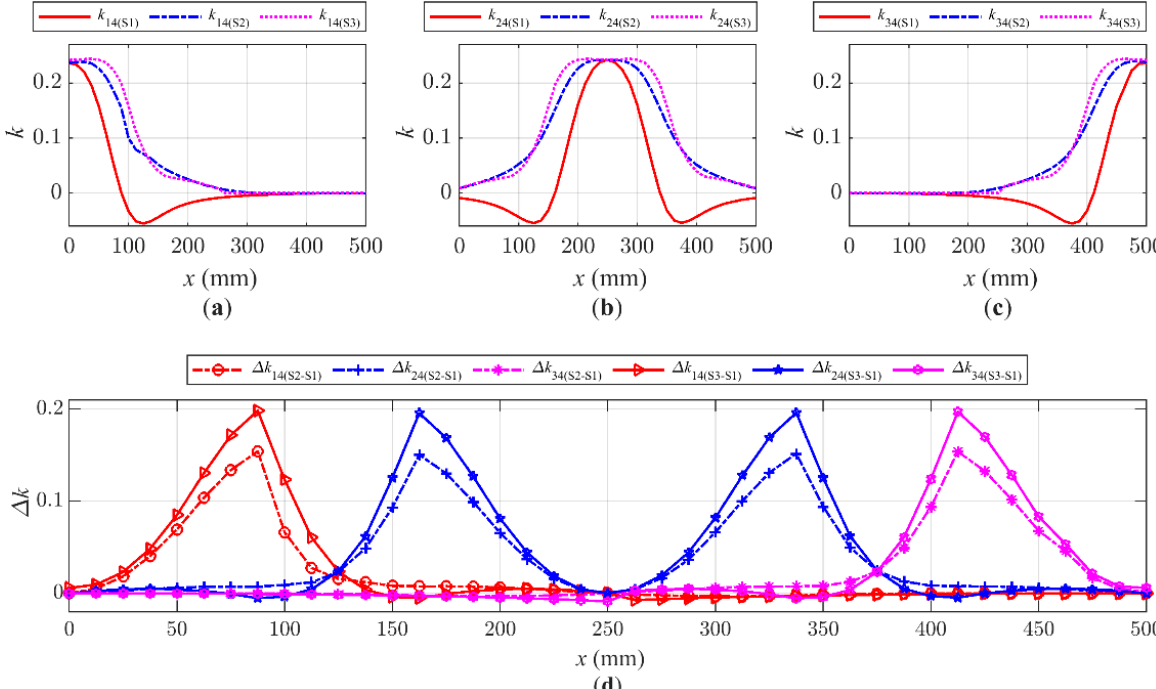
Figure 13. Modeling results under different conditions: ( a ) k 14 coefficients, ( b ) k 24 coefficients, ( c ) k 34 coefficients and ( d ) increase in the coupling coefficient in comparison to the conventional solution.